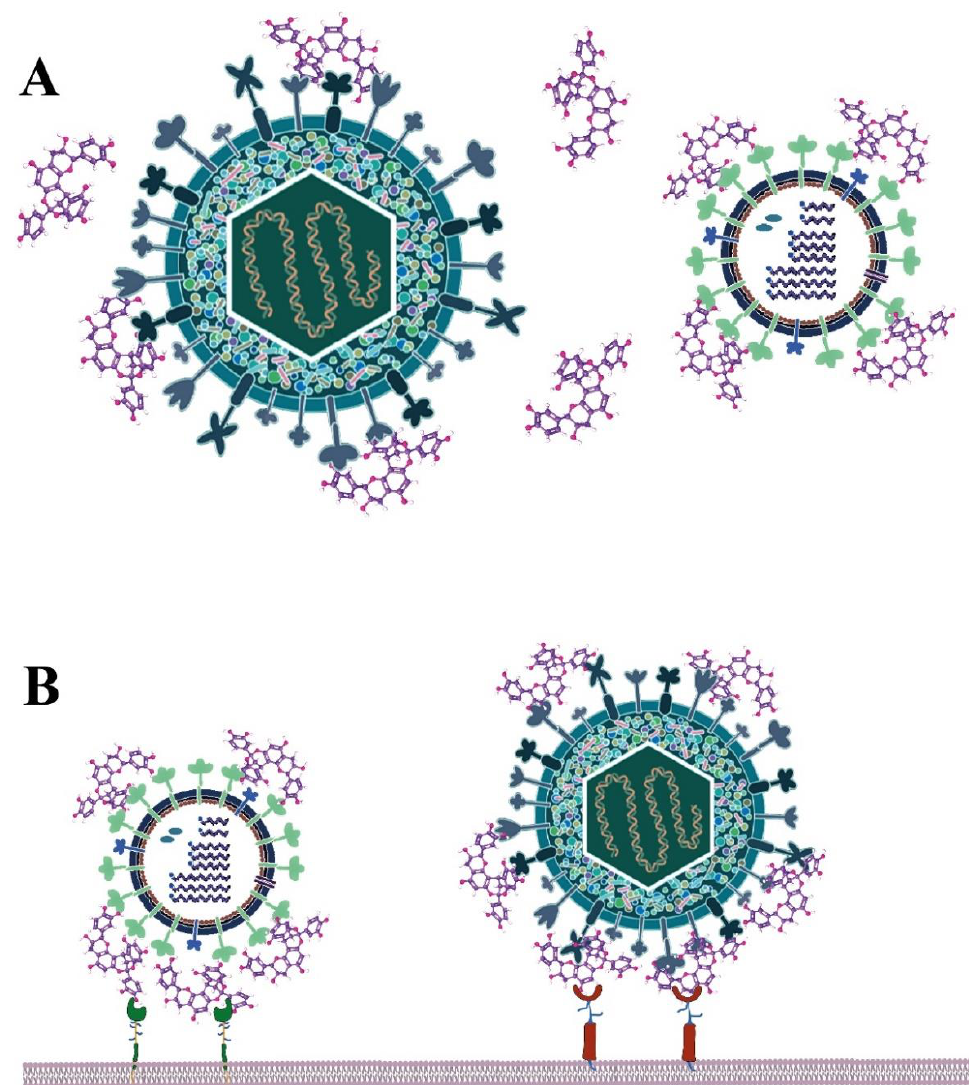
Figure 3. A proposed mechanism of action for the broad-spectrum antiviral activity of type-A PACs. ( A ) Tampering with virion capsid or envelope glycoproteins. ( B ) Masking/blocking virion binding sites to cellular receptors.